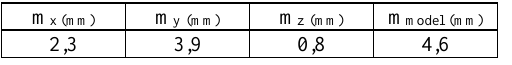
Table 2a. Accuracy analysis of 3D object model (Mirrored